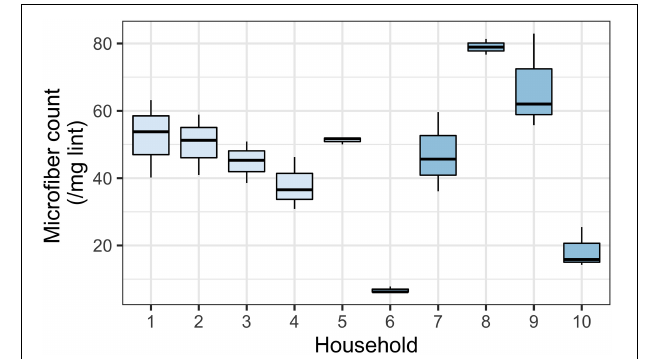
FIGURE 3 | Mean number of microfibers per mg of household lint (across 10 replicate households). Boxes show the distribution of microfibers across the three subsamples per household sample. Household 1–5 were sampled during the first collection and household 6–10 were sampled during the second collection. The values plotted here are microfibers only (i.e., fragments and foam not included in these counts). Boxes represent 25th–75th percentiles; dark lines, medians; whiskers, 1.5 × the interquartile range (IQR).